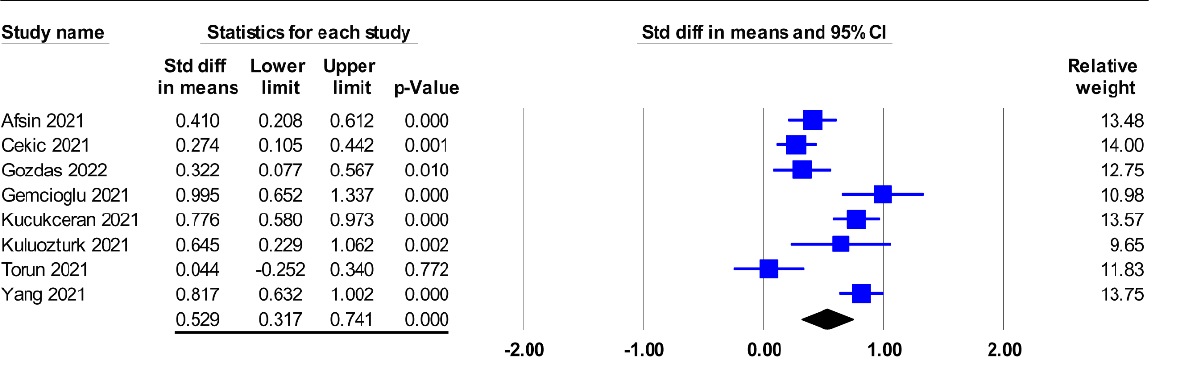
Figure 3. Forest plot comparing fibrinogen-to-albumin (F/A) ratio between poor and good prognosis groups, showing a higher F/A ratio in the former compared to the latter (SMD: 0.529, 95% CI: 0.317 to 0.741, p < 0.001, I 2 = 84.8%) [24,25,32–35,37,38]. Std diff, standardized difference; CI, confidence interval.